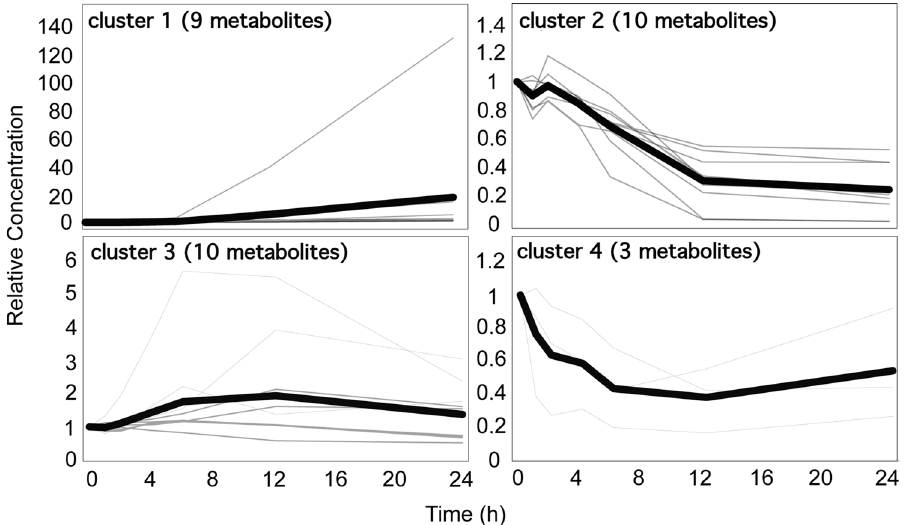
Figure 4. K-means clustering to infer pattern of metabolites during X. citri growth. Graphs represent the metabolite pattern normalized to its respective time point 0 (i.e., before treatment), which are displayed in gray. The mean of each cluster is represented by the black